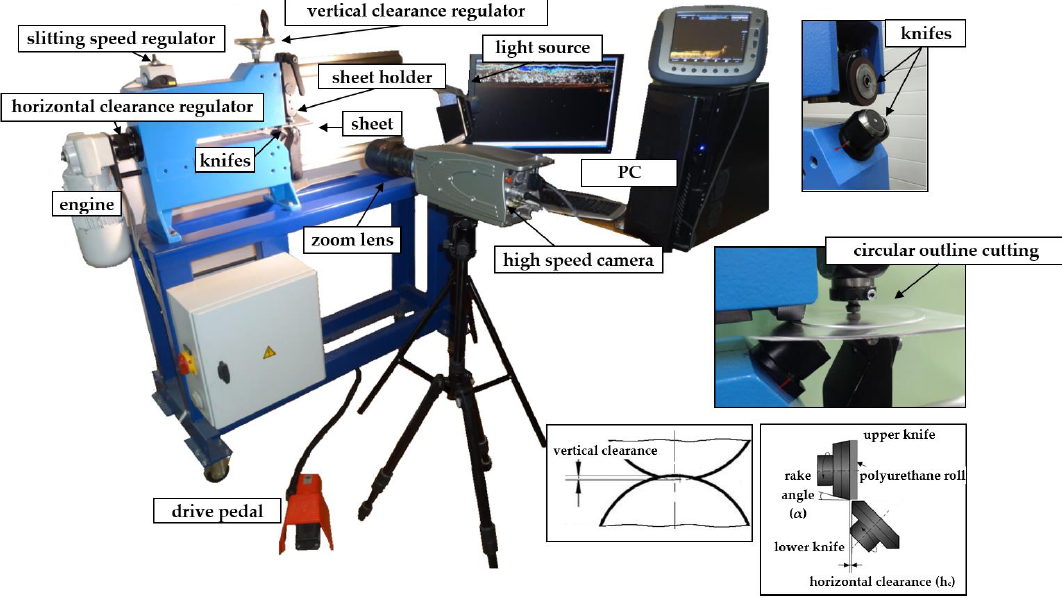
Figure 1. Experimental equipment. Table 1. Mechanical and thermal properties of AA6111-T4 aluminum alloy (at T = 20 °C) .